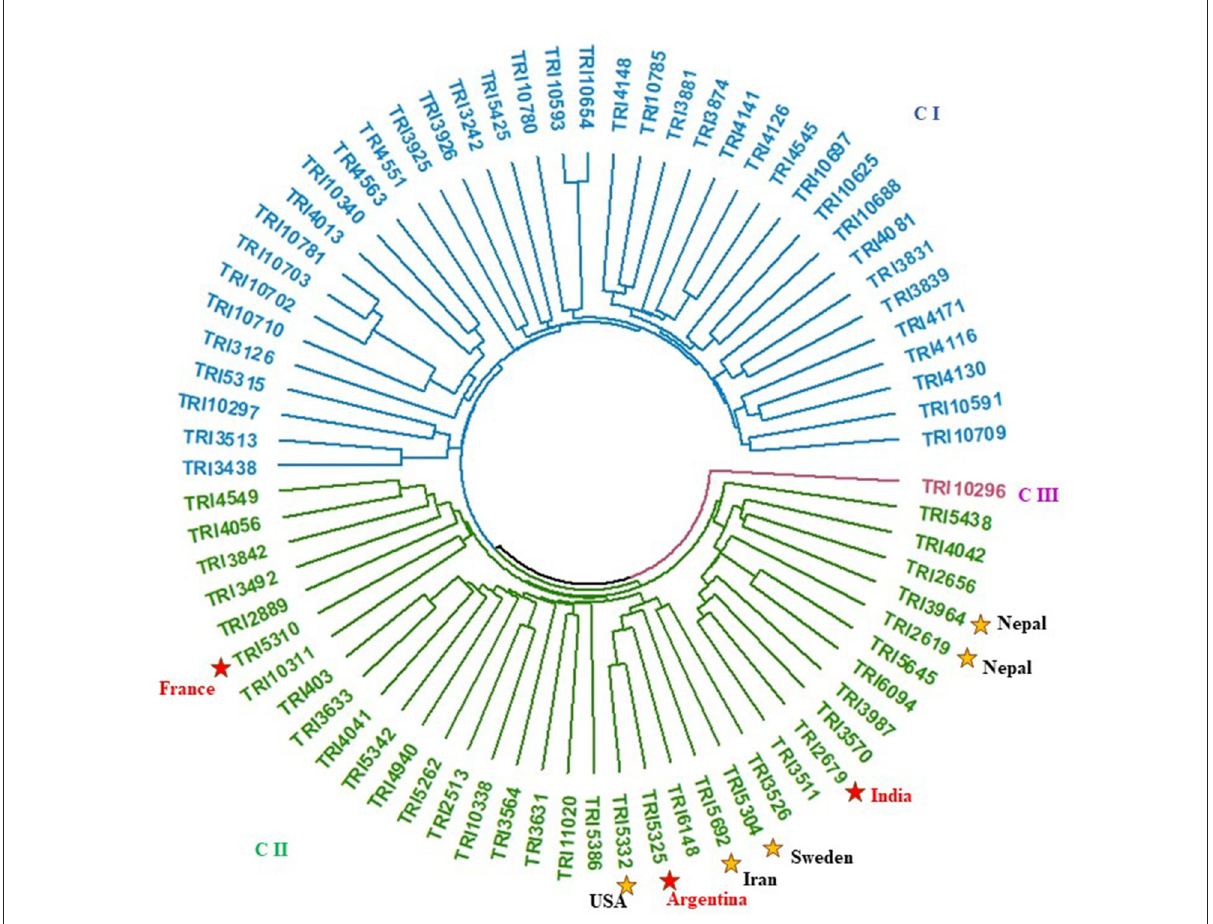
FIGURE6 Dendrogram analysis based on genetic diversity among all